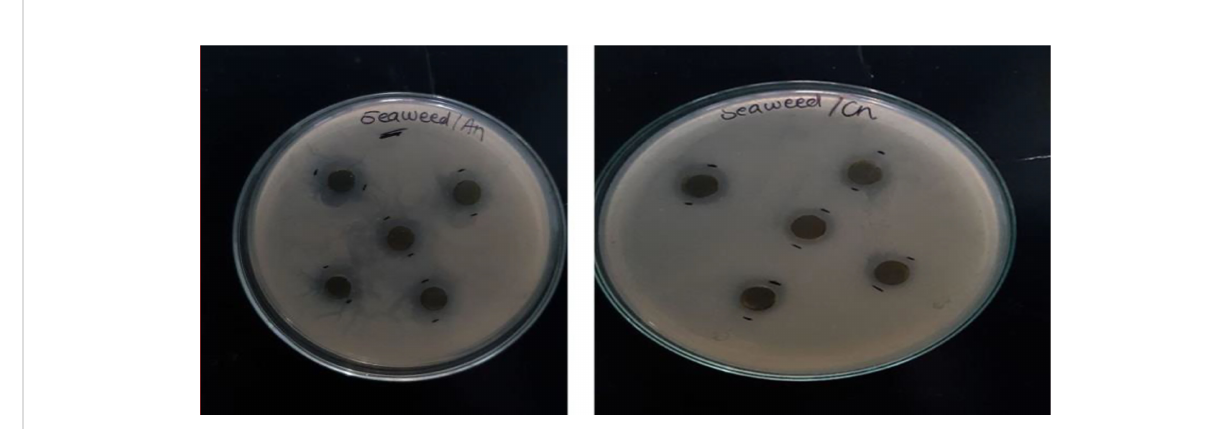
FIGURE 5 Inhibition zone antifungal activity of Sargassum aqueous